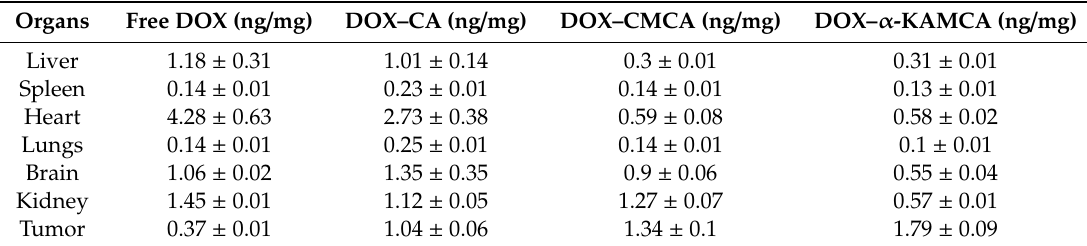
Table 3. Organ distribution of free DOX, DOX-loaded CA NPs, DOX-loaded CMCA NPs, and DOX-loaded α -KAMCA NPs at 24 h of treatment ( n =